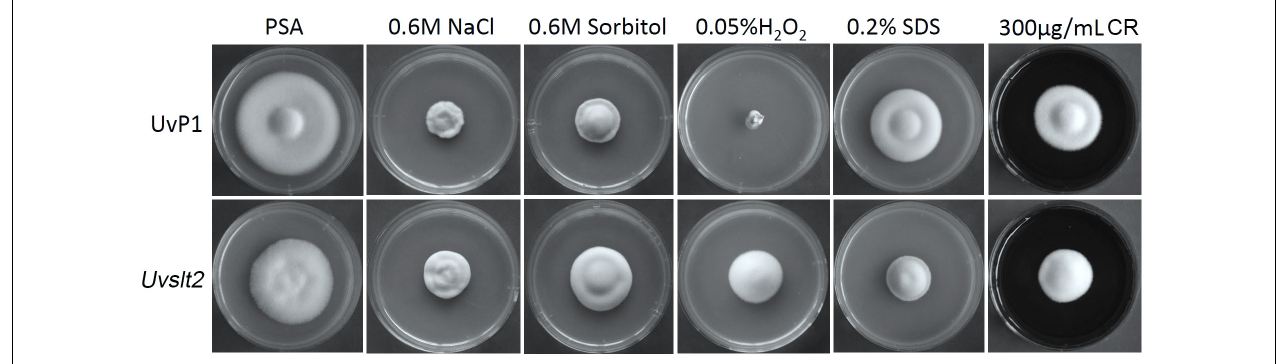
FIGURE 5 | Defects of the Uvslt2 mutant in response to different stresses. The wild-type strain P1 and Uvslt2 mutant were cultured on regular PSA plates or PSA with 0.6 NaCl, 0.6 M sorbitol, 0.05% H 2 O 2 , 0.2% SDS, or 300 µ g/ml Congo red (CR). Typical cultures were photographed after incubation for 14